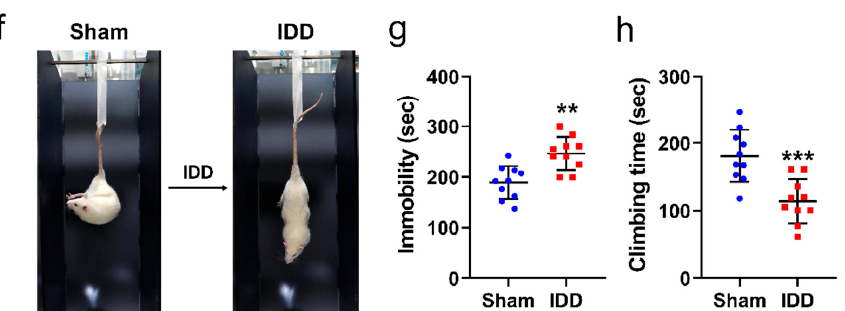
Figure 1. ( a ) Scheme of surgical sequence for intervertebral disc degeneration and experimental design; ( b ) Process of exposing the L4/5 and L5/6 discs and aspirating the NP to build the IDD model. ( c , d ) Latency (seconds) of paw withdrawal response in the left and right hindlimbs of the sham and IDD groups using the von-Frey test for up to 4 weeks ( n = 10/group); ( e ) Behavioral assessments for the sham and IDD groups using the horizontal test for up to 4 weeks (n = 10/group); ( f ) Images representing mobility (attempting to reach a floor or wall) and immobility (extending without moving) of rats; ( g , h ) Immobility and climbing time (seconds) of sham and IDD groups using tail suspension test at 4 weeks ( n = 10/group). The number n is the number of individual animals used for evaluation. Data are expressed as the mean ± SEM. Significant differences indicated as * p < 0.05, ** p < 0.01, and *** p < 0.001 vs. sham group were analyzed via unpaired t -tests with Welch’s correction. 5mc, 5-methylcytosine; 5hmc, 5-hydroxymethylcytosine; AF, annulus fibrosus; IDD, intervertebral disc degeneration; NP, nucleus pulposus; SD, Sprague-Dawley; SEM, standard error of the mean.